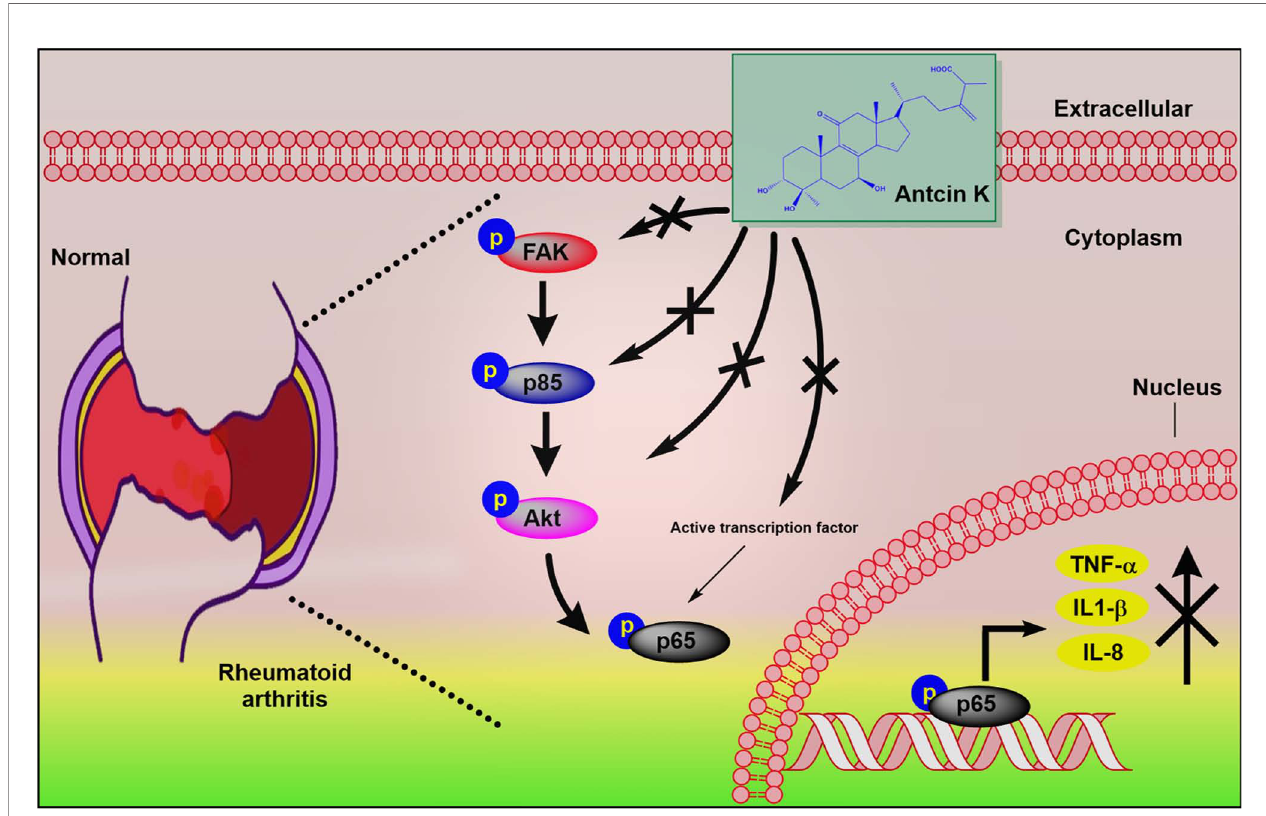
FIGURE 9 | Schematic diagram summarizes the mechanism whereby Antcin K inhibits proin fl ammatory cytokine production. Antcin K inhibits TNF- a , IL-1 b and IL-8 production in human RA synovial fi broblasts and in serum and synovial tissue from CIA mice. These anti-in fl ammatory effects occur through the FAK/PI3K, AKT, and NF- k B signaling